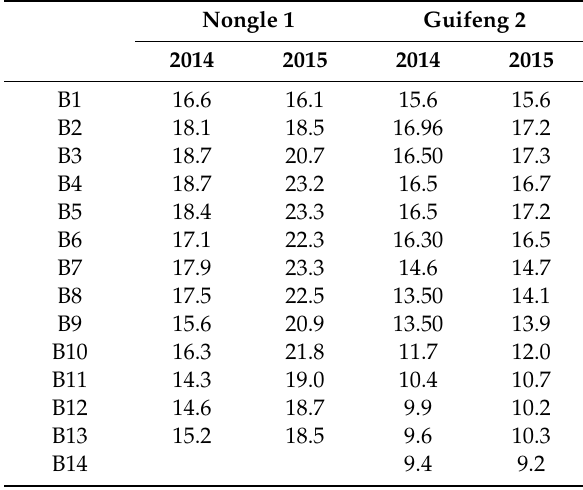
Table 5. The numbers of spikelets of each primary-branch at di ff erent positions for Nongle 1 and Guifeng 2 in 2014 and 2015. B1 to B14 represent the 1st primary-branch grains to the 14th primary-branch grains from the top to the base of the panicle for Nongle 1 and Guifeng